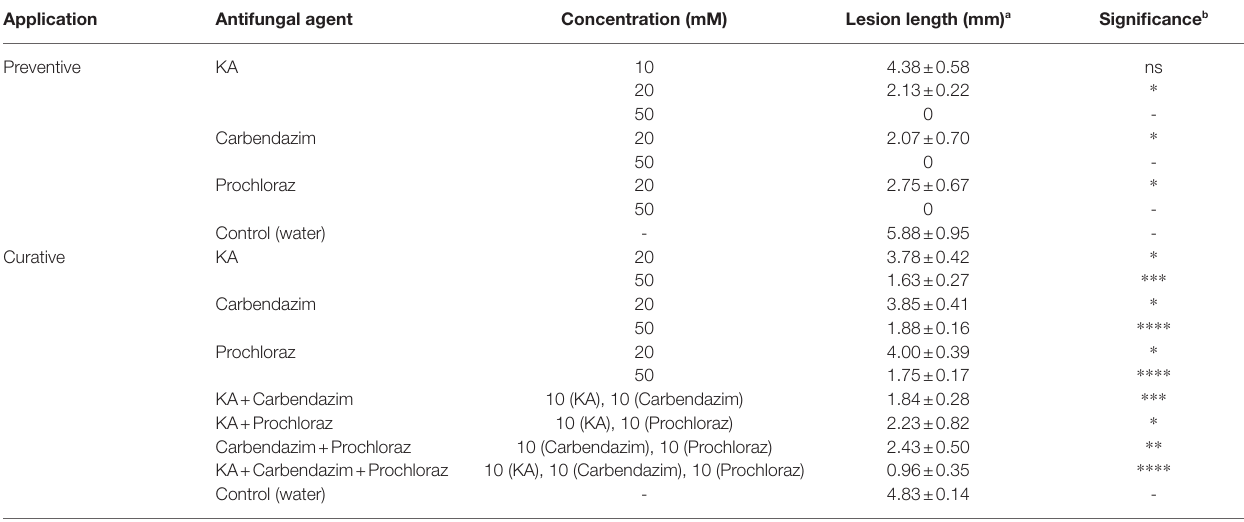
TABLE 1 | Efficacy of kojic acid (KA; MW: 142.1 g/mol) and commercial fungicides carbendazim (MW: 191.2 g/mol), and prochloraz (MW: 376.7 g/mol) for the control of Sclerotinia sclerotiorum in soybean pods.